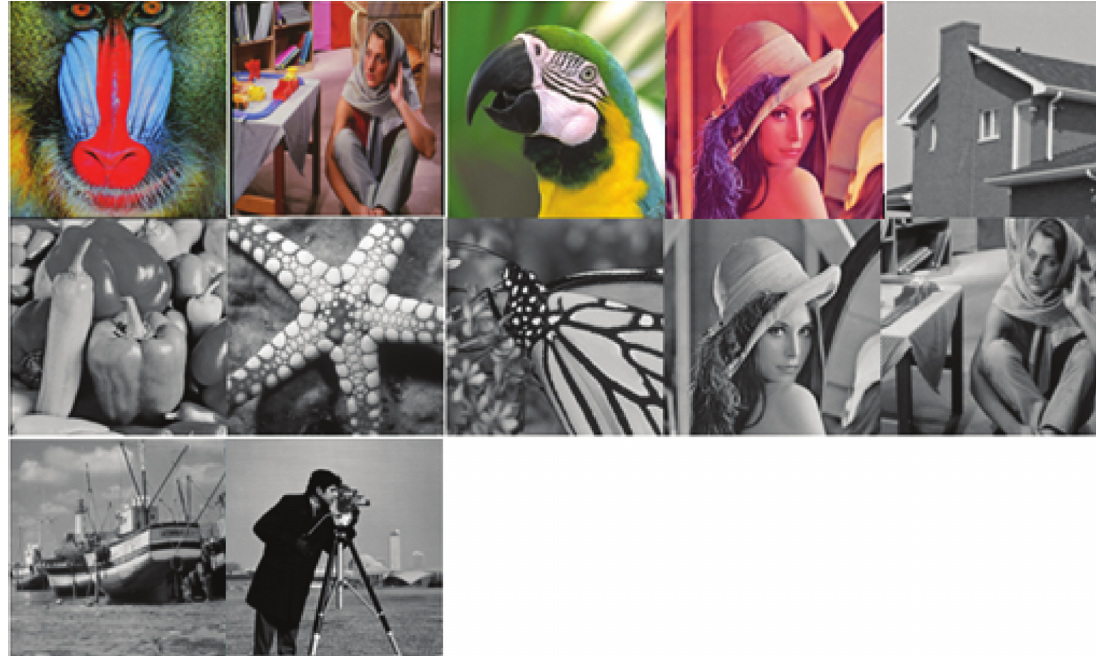
Figure 4: All Experimental Test